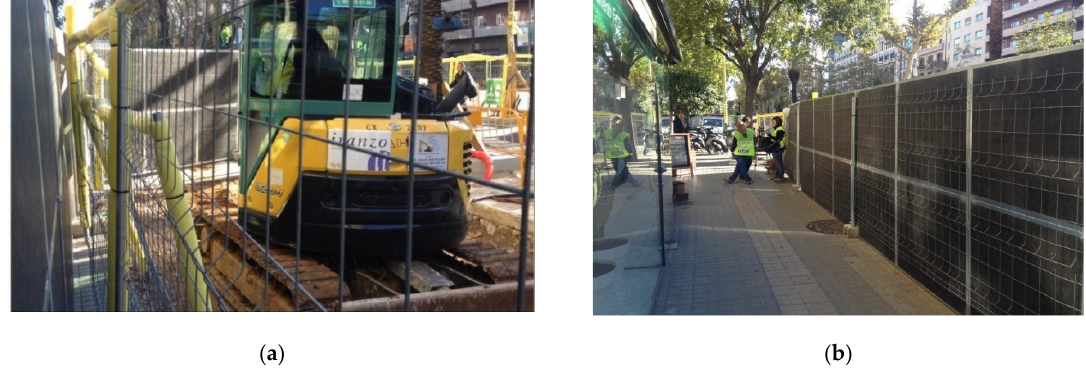
Figure 2. On-site noise control barriers. ( a ) Construction site area. ( b ) Sidewalk and neighboring